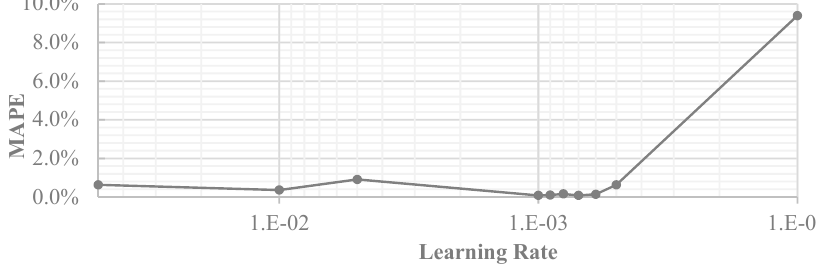
Figure 9. Selection of the learning rate for the DNN model.